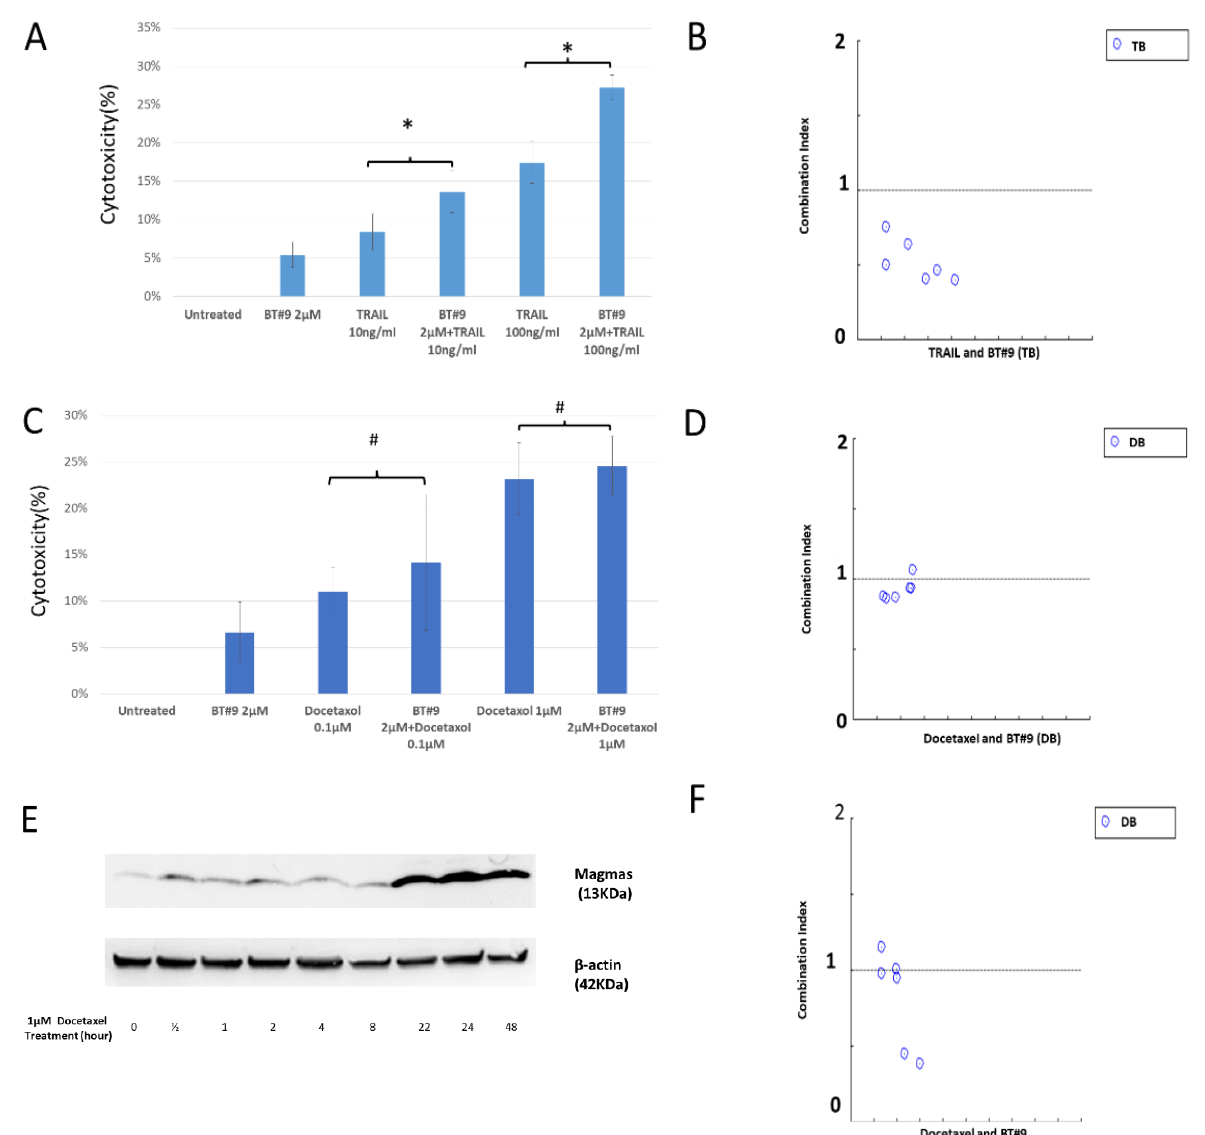
Figure 6. The combination of BT#9 and TRAIL or Docetaxel. ( A , B ) The representative result of the combination of BT#9 (2 µ M) and TRAIL (10 ng/mL or 100 ng/mL). The whole CI of BT#9 (1, 2 or 5 µ M) and TRAIL (10 or 100 ng/mL) is between 0.22 and 0.72. ( C , D ) The representative result of the combination between BT#9 (2 µ M) and Docetaxel (0.1 µ M or 1 µ M) The whole CI of the concurrent combination of BT#9 (1, 2 or 5 µ M) and Docetaxel (0.1 or 1 µ M) is between 0.86 and 1.06. ( E ) The Magmas expression of PC-3 cells was upregulated around 24 h or later after 1 µ M Docetaxel treatment. ( F ) The whole CI of the sequential combination of BT#9 (1, 2 or 5 µ M) and Docetaxel (0.1 or 1 µ M) is between 0.39 and 1.15. Among all 6 dots, upper 4 dots (CI = 0.95–1.15) represent CI for Docetaxel (0.1 or 1 µ M) and BT#9 (1 or 2 M µ ), lower 2 dots (CI = 0.39–0.45) represent CI for Docetaxel (0.1 or 1 µ M) and BT#9(5 µ M). Each experiment was repeated three times. # p > 0.05, * p < 0.05 (Unpaired two-tailed t